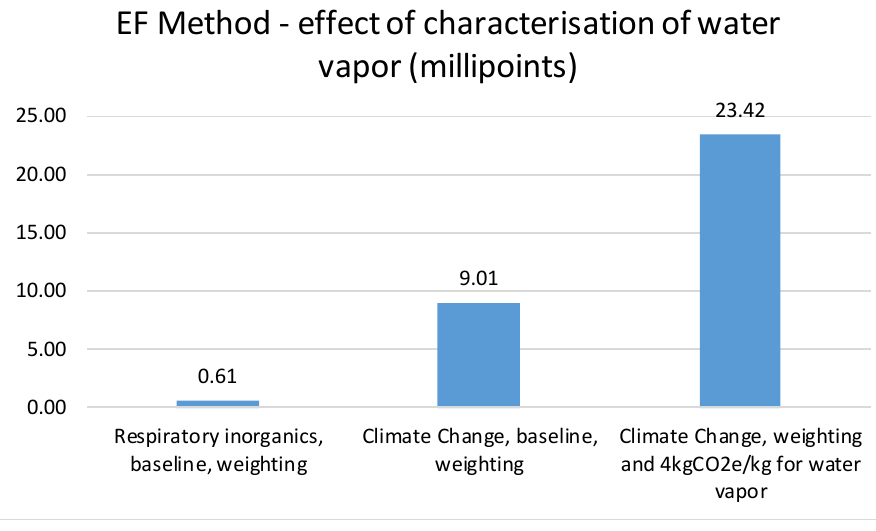
Figure 2. EF method results per kg fuel for air transport.